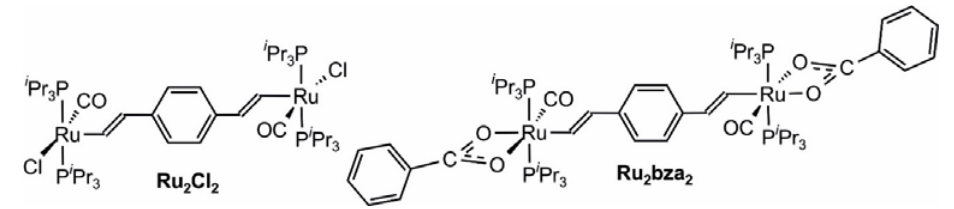
Figure 5. The diruthenium reference complexes Ru 2 Cl 2 and Ru 2 bza 2 . Table 1. Electrochemistry data for macrocycles 1 – 4 and the diruthenium analogs Ru 2 bza 2 and Ru 2 Cl 2 1 .